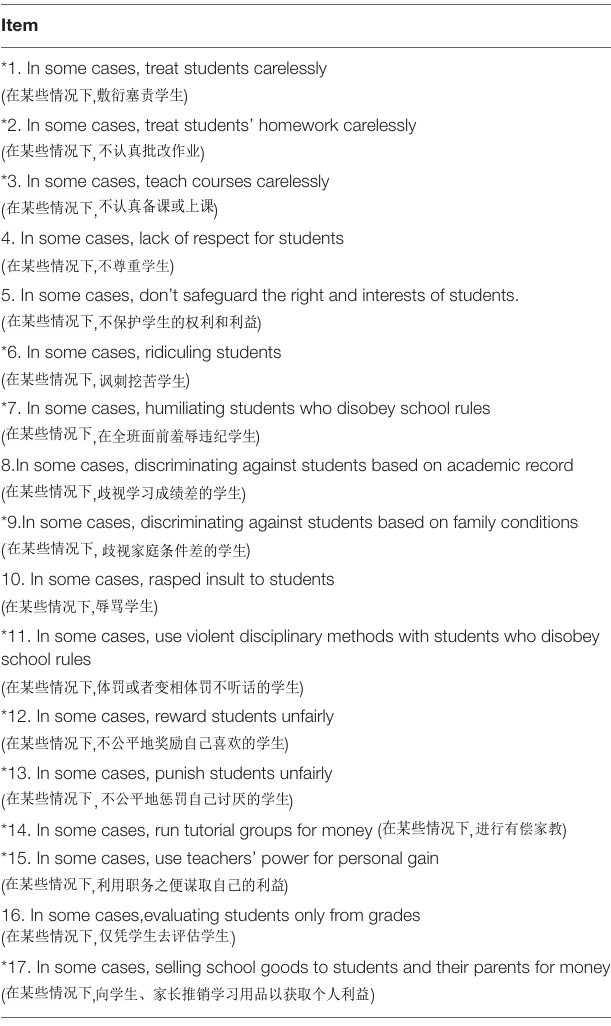
TABLE 1 | The initial 17-item unethical professional behavior tendencies scale.